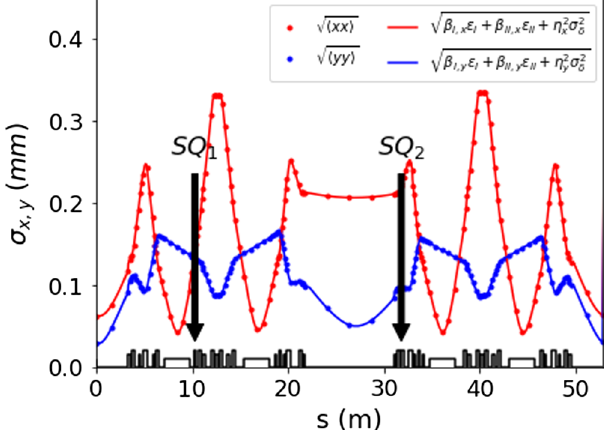
2. Beam sizes obtained with the SLIM analysis (dots) and Ripken parametrization (line) in the presence of linear coupling. The locations of two skew quadrupoles are marked. By assigning them the same j K 1 j value, but alternating polarities along the ring, the vertical emittance and overall beam sizes will blow up. The dotted lines are the second moments obtained with the SLIM analysis, and the solid lines are computed with the coupled Twiss functions in Ripken parametrization. Nevertheless, for both cases, the equilibrium emittances ϵ I;II and energy spread σ δ need to be computed with the SLIM analysis